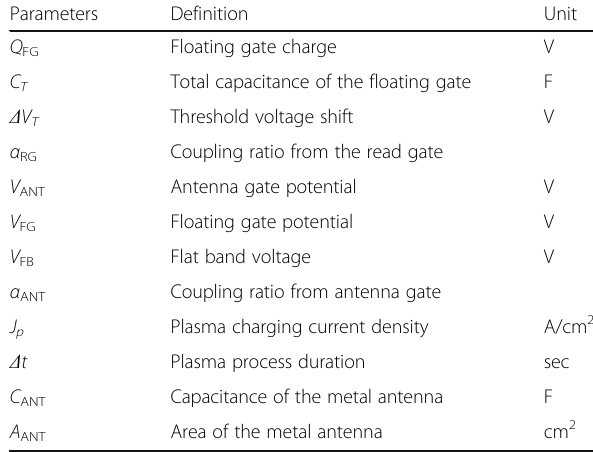
Table 1 Parameters in Eqs. (2) – (4) for estimating